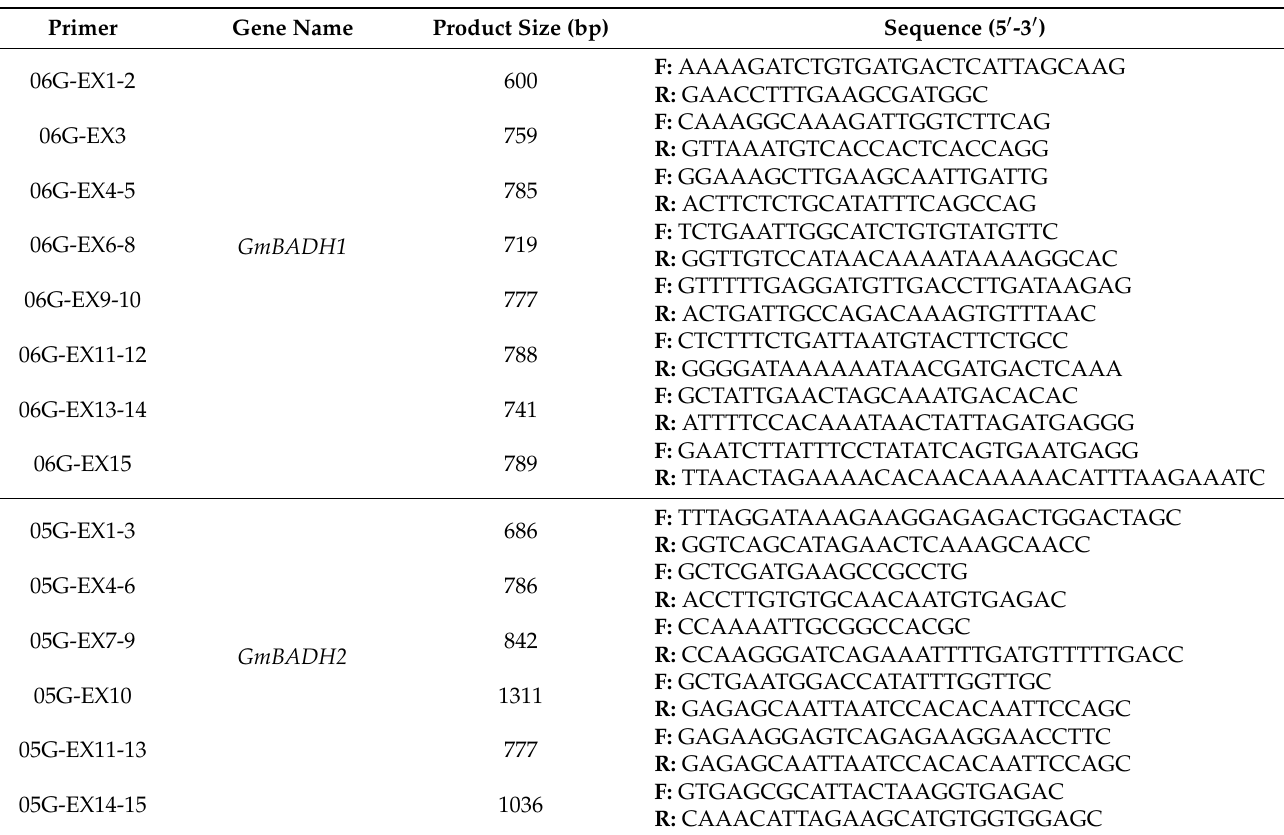
Table 4. Primers designed for the candidate genes GmBADH1 (Glyma06g19820) and GmBADH2